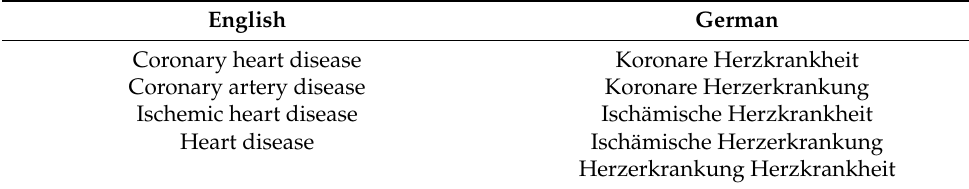
Table A1. List of all search terms for coronary heart